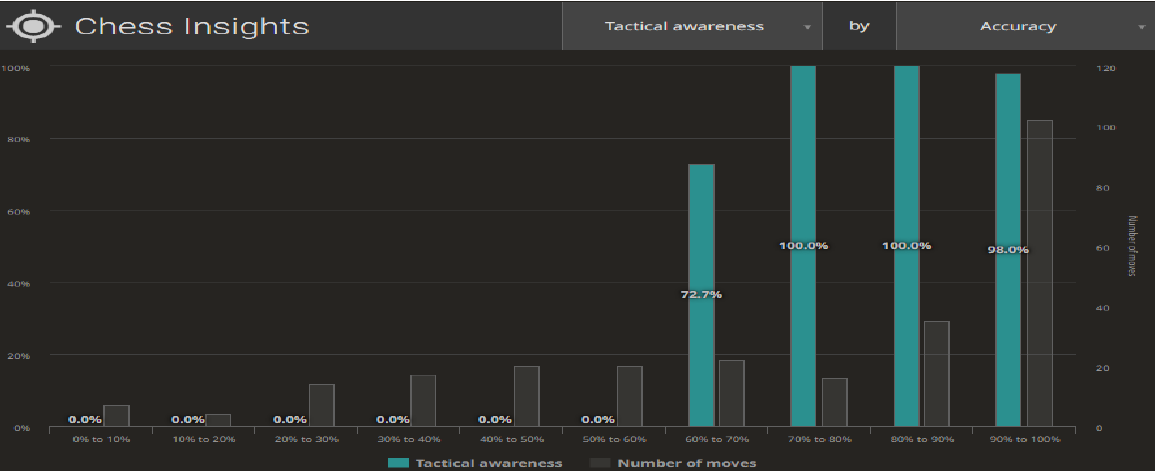
Figure 9. Statistics on taking advantage of opponent ’ s mistakes. Source: lichess.org.